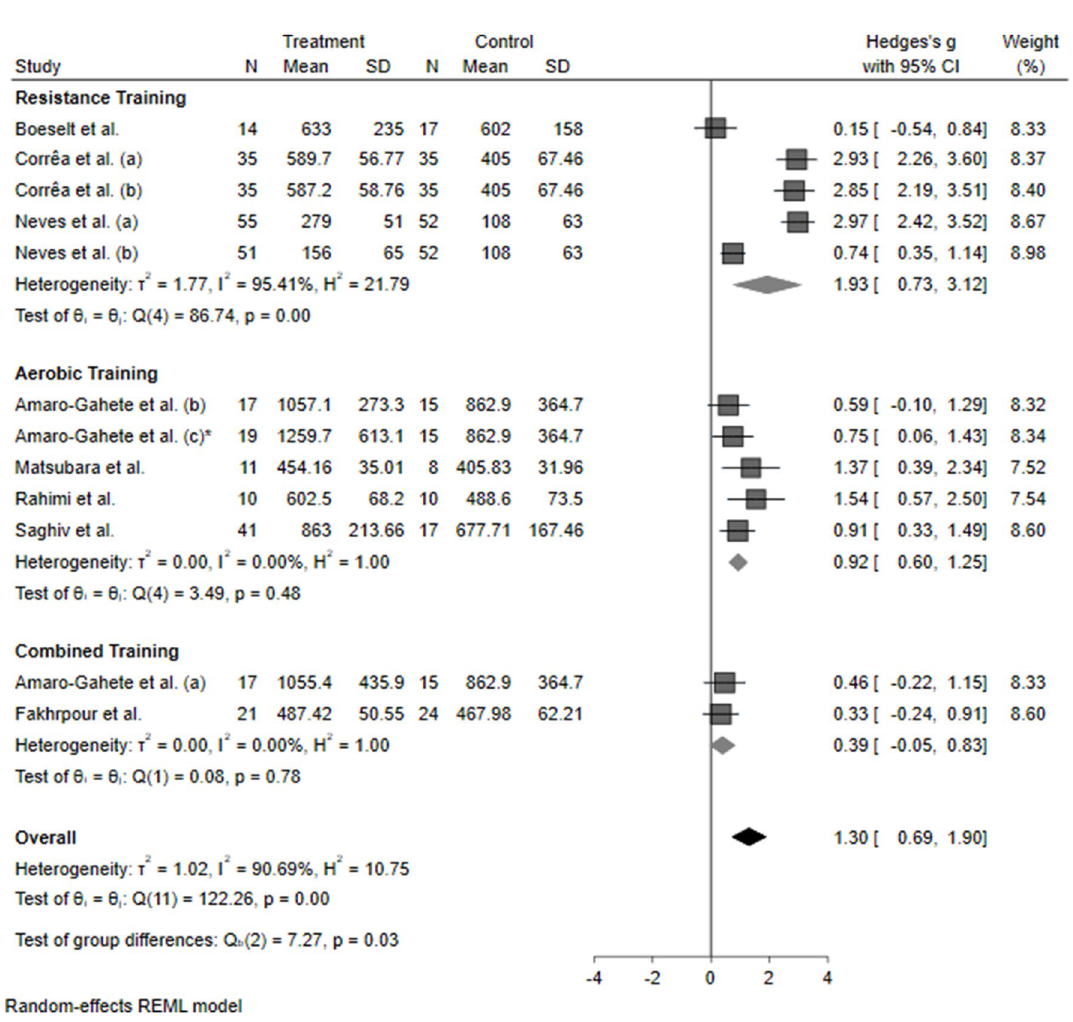
Figure 3. Forest plot of the results from a random-effects meta-analysis shown as Hedges’ g with 95% CIs of aerobic, resistance, and combined training on Klotho concentrations. For each study, the square represents the Hedges’ g of the intervention effect with the horizontal line intersecting it as the lower and upper limits of the 95% CI. The rhombi represent the weighted the aerobic, resistance, and combined training.